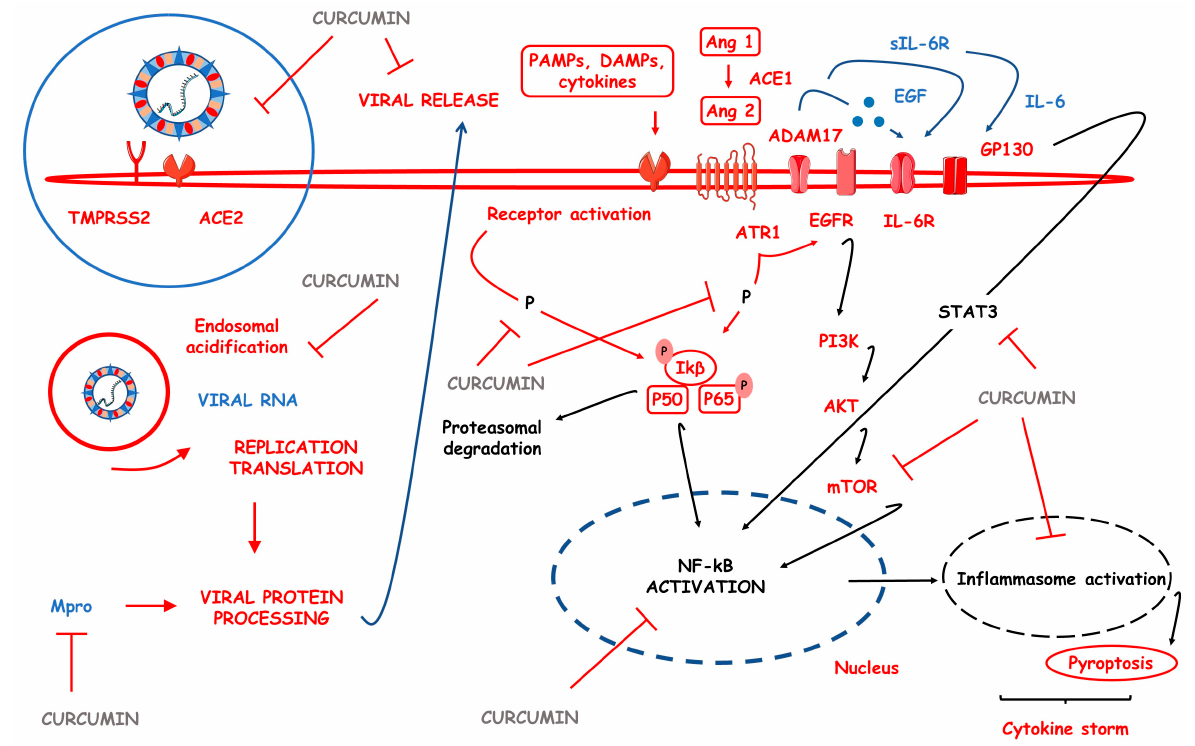
Figure 3. Effects of CUR not only on the inflammatory vias associated with COVID-19, but also with SARS-CoV-2 viral processing and release processes. CUR exerts principally anti-inflammatory and antioxidant effects against COVID-19, but also conducts immunomodulatory effects by controlling the expression of immunological genes. Regarding its use, CUR can also promote symptoms-relief during COVID-19 infection. ACE1, angiotensin-converting enzyme 1; ACE2, angiotensin-converting enzyme 2; ADAM17, disintegrin and metalloprotease 17; Ang 1, angiotensin 1; Ang 2, angiotensin 2; AKT, Alpha serine/threonine protein kinase; ATR1, angiotensin 1 receptor; DAMPs, damage- associated molecular patterns; EGF, epidermal growth factor; EGFR, epidermal growth factor receptor; GP130, glycoprotein 130; Ik β , inhibitor of nuclear factor kappa β ; IL, interleukin; IL-6R, interleukin 6 receptor; Mpro, main protease; mTOR, mammalian-target of rapamycin; NF-kB, nuclear factor kappa B; P50, the nuclear factor kappa B p50 heterodimer; P65, the nuclear factor kappa B p65 heterodimer; PAMPs, pathogen-associated molecular patterns; PI3K, phosphatidylinositol-3 kinase; sIL-6R, soluble form of the interleukin 6 receptor; TMPRSS2, transmembrane protease serine 2. Hanafy & El-Kemary [99] studied the effects of silymarin/CUR-loaded albumin NPs coated by CH muco-inhalable delivery system as an anti-inflammatory against COVID- Ahmadi et al. [101], in a triple-blind, placebo-controlled, randomized clinical 19 infection in vivo. The results showed that the mice levels of IL-6 and c reactive protein (CRP) were significantly reduced due to the nano treatment in comparison with the free treatment by not encapsulated or placebo capsules. However, only silymarin was effective in exerting antiviral therapy against COVID-19 and, therefore, ameliorated the histo- pathological parameters of the disease.